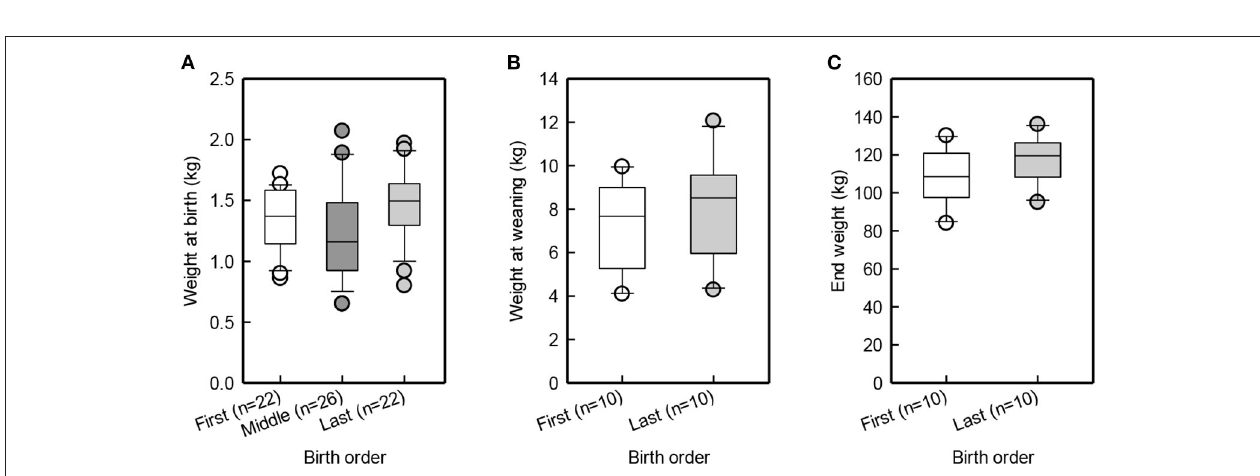
FIGURE 3 | Box and whisker plot of birth weight of first, middle, and last-born piglets (A) , weaning weight (B) , and end weight (C) of first and last-born